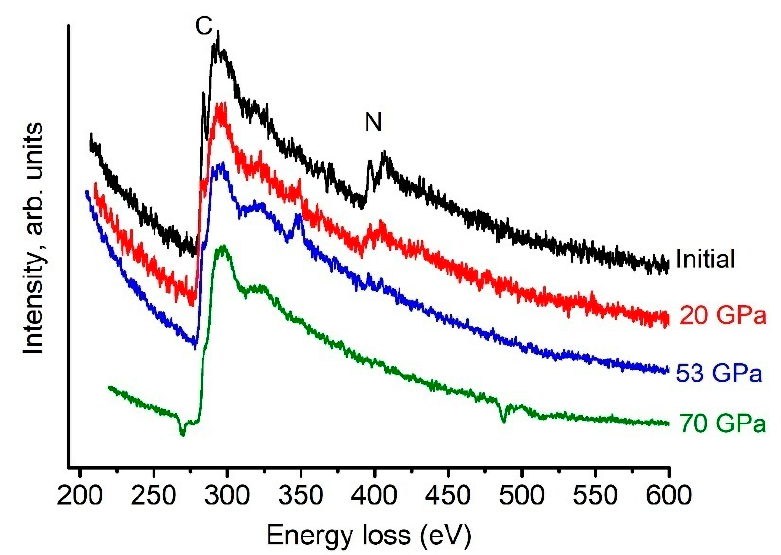
Figure 6. EELS spectra measured on quenched C-N phases. The exposure time when receiving the EELS spectrum is a few seconds. The particle size is several nanometers. Table 2. The sp 2 content using the approach described in Reference [26]. The area under the sp 2 peak (280–285 eV) was divided by the value of the area of the sp 3 peak (286–292 eV). As we can see, the concentration of nitrogen decreases, as well as the concentration of the sp 2 bonds, with increasing pressure in the quenched specimens. Sample